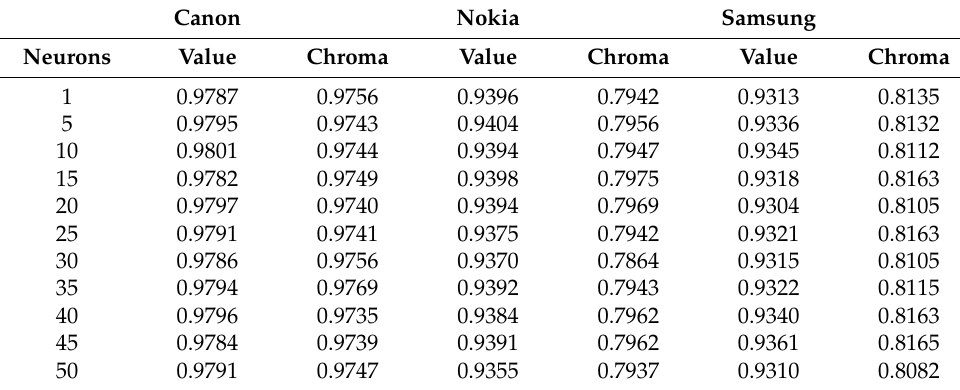
Table 6. Results of the estimation of the value and chroma.